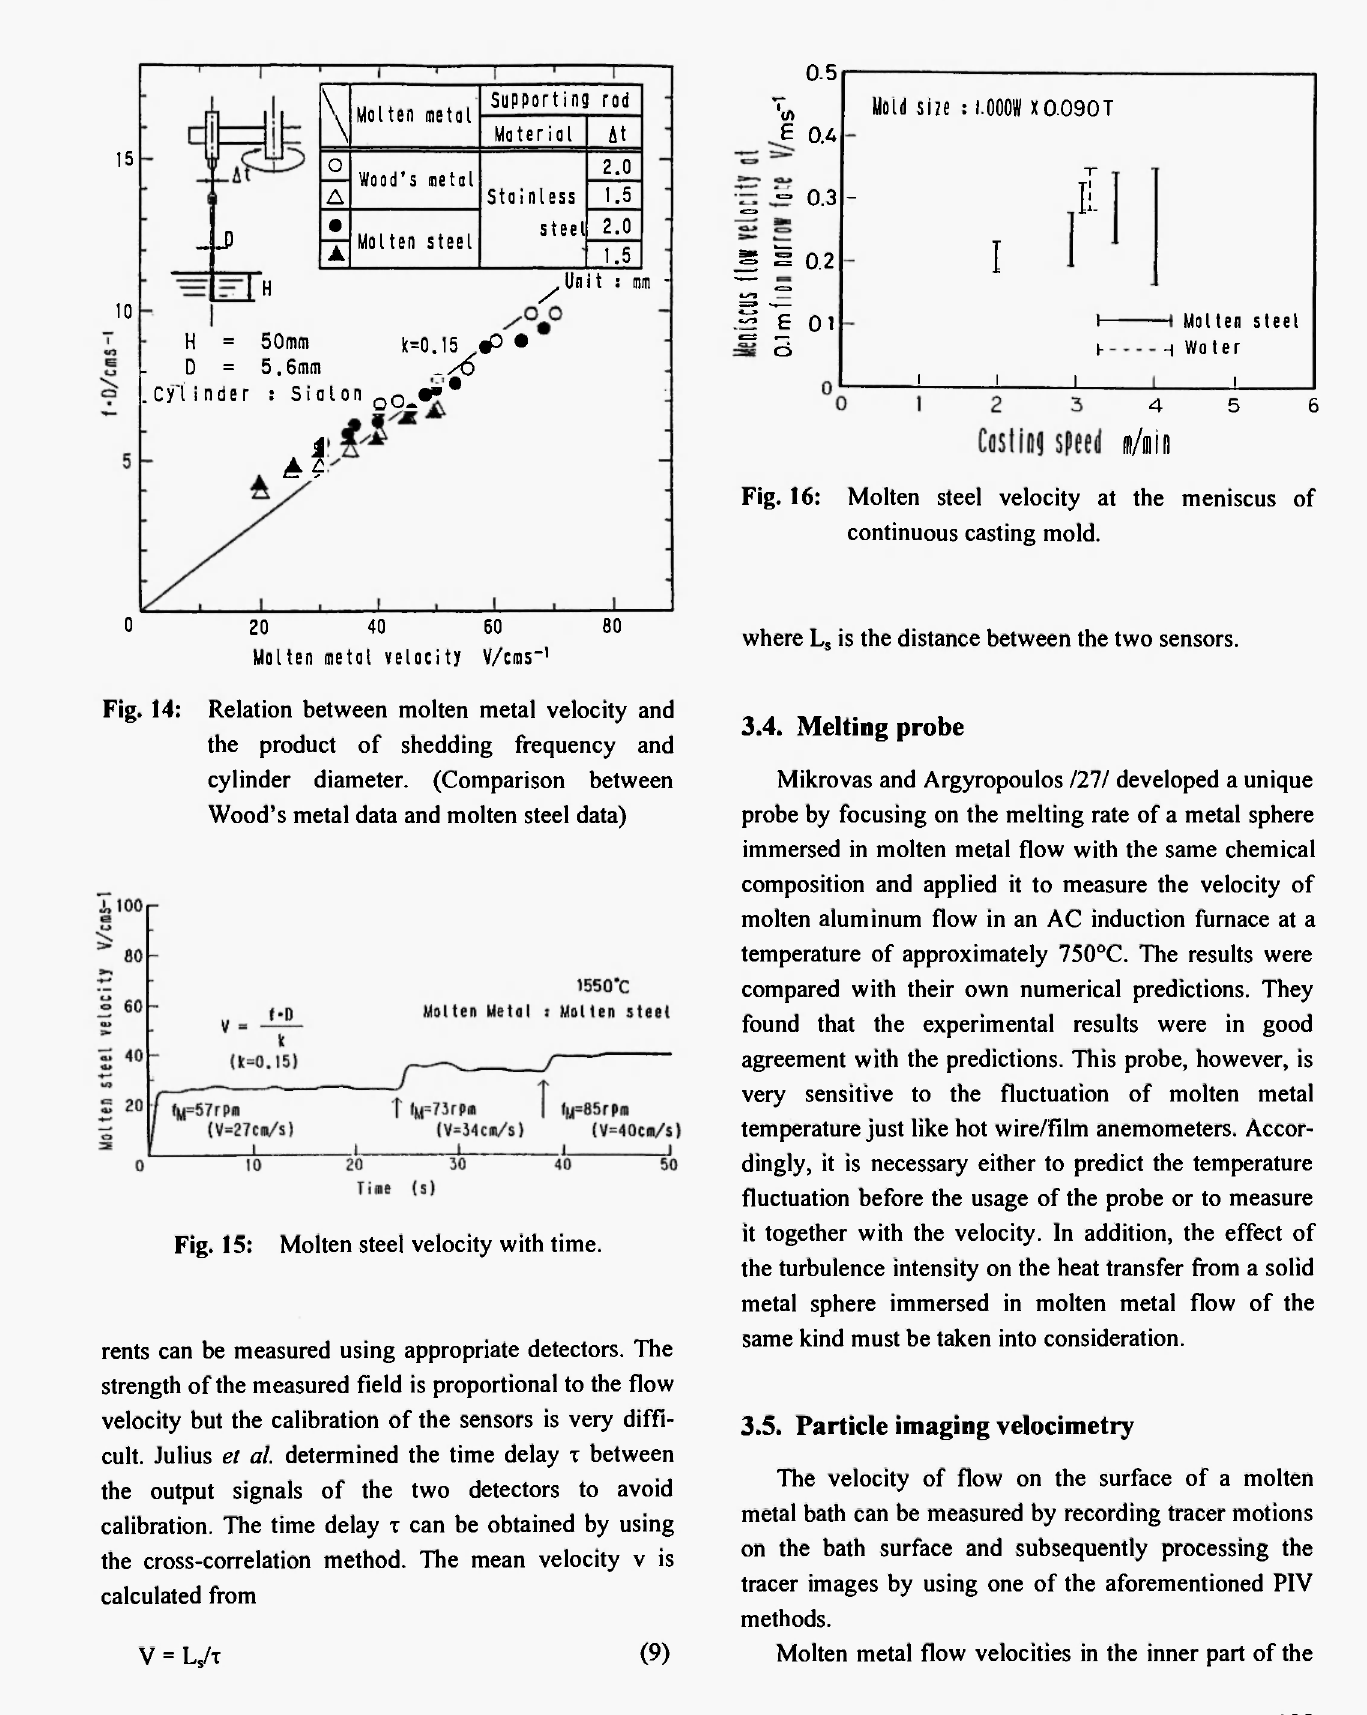
Fig. 16: Molten steel velocity at the meniscus of continuous casting mold.